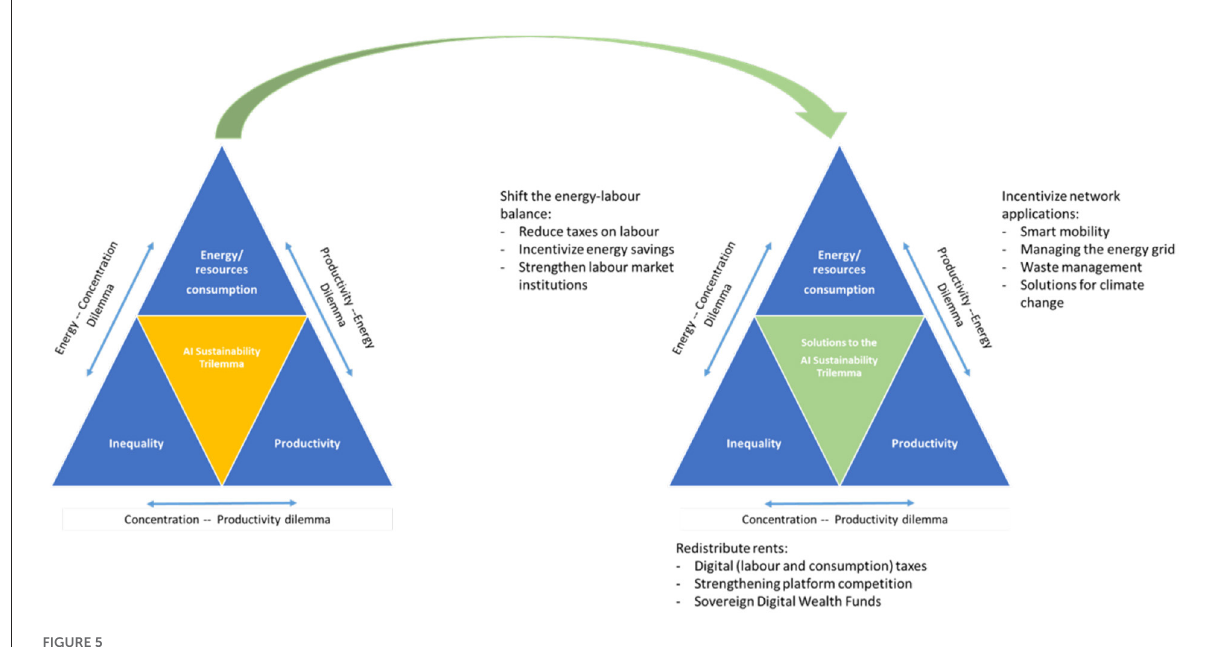
FIGURE5 Solving the AI